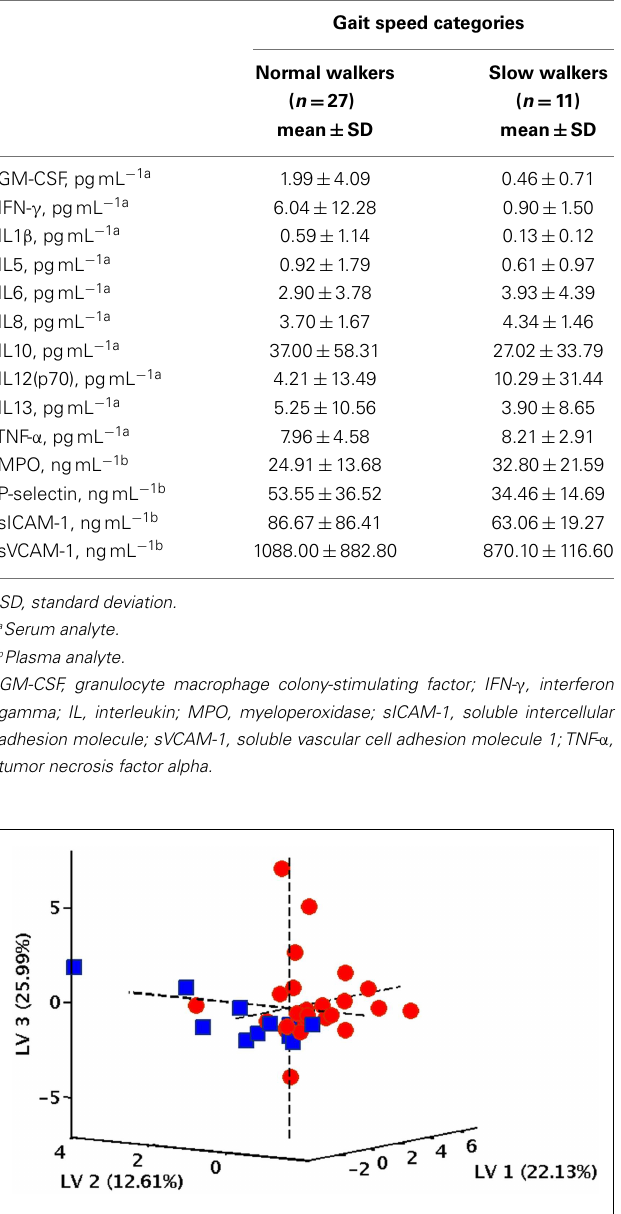
FIGURE 1 | Projection of participants onto the space spanned by the first three latent variables (LVs) of the PLS-DA model . Red circles correspond to normal walkers, blue squares identify slow